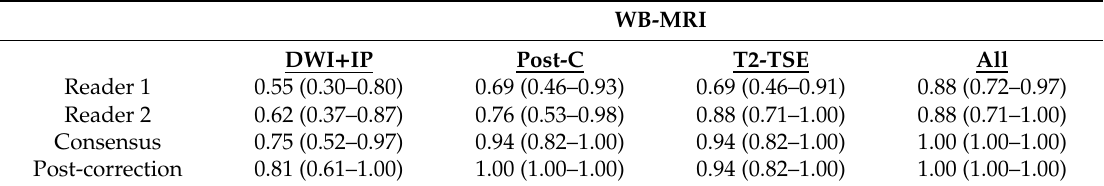
Table 7. Evaluation of di ff erent MRI sequences as part of the WB-MRI protocol for overall staging compared to enhanced reference standard staging. Weighted kappa agreement and 95% confidence interval are shown.